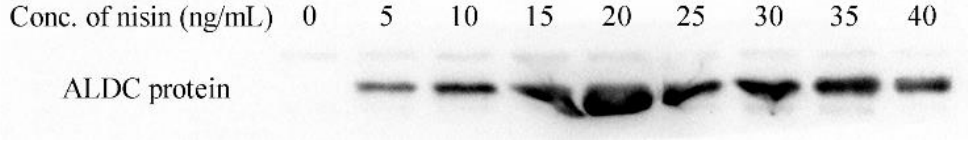
Figure 4. Effect of nisin concentrations on ALDC expression.